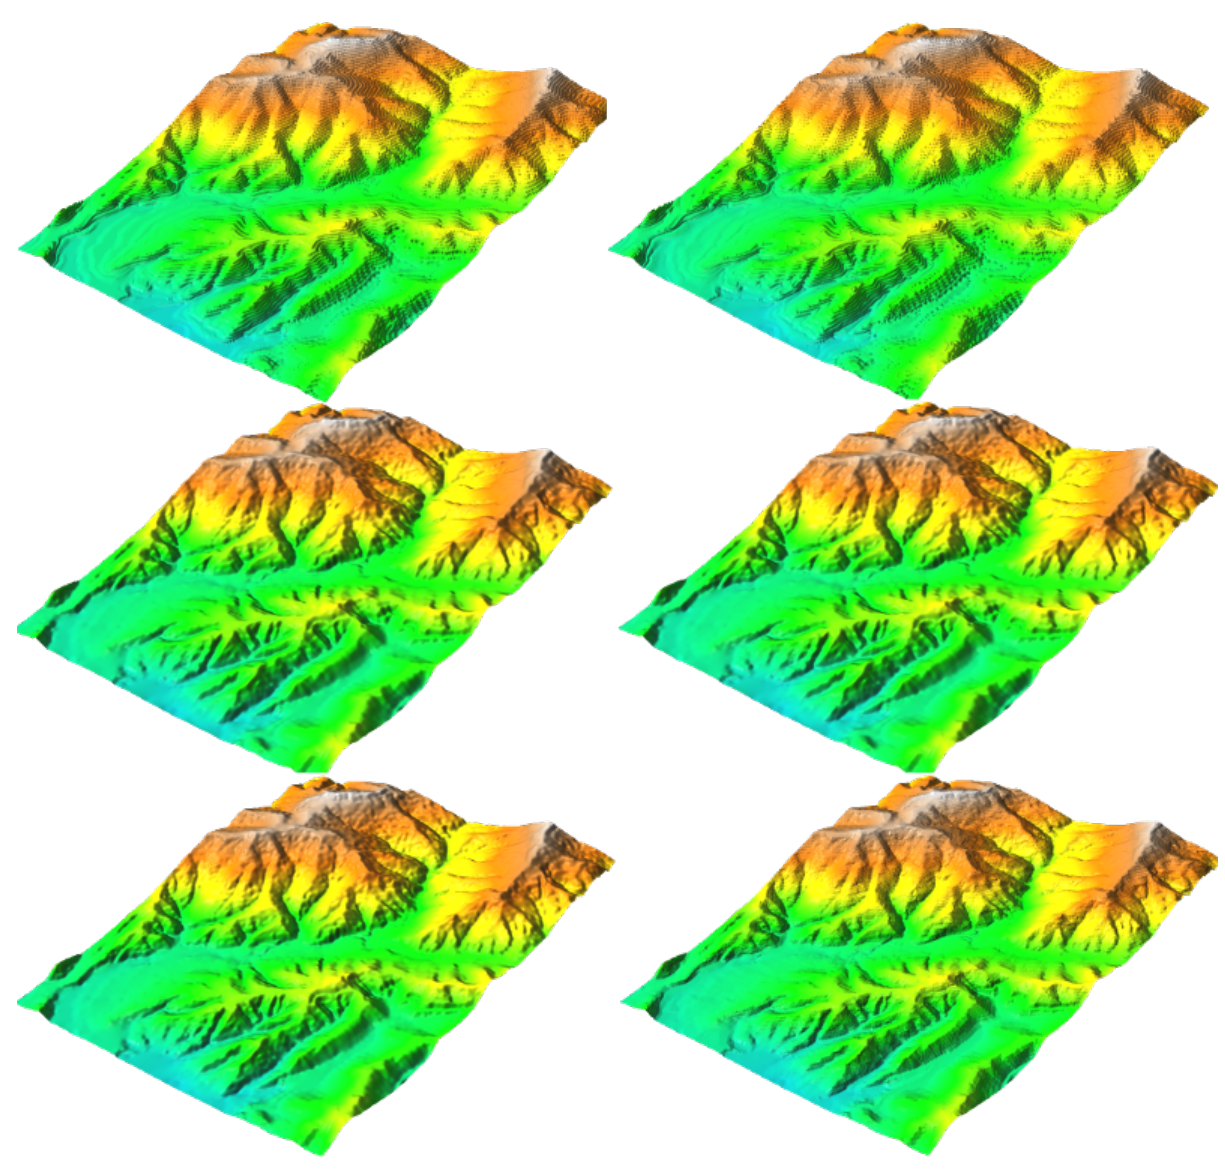
Figure 3. 3D representation of the interpolated maps by (from left to right and top to bottom) vsurfidw24 (rsurfidw24),vsurfidw64 (rsurfidw64), vsurfbspline bilin,vsurfbspline bicub, vsurfrst and